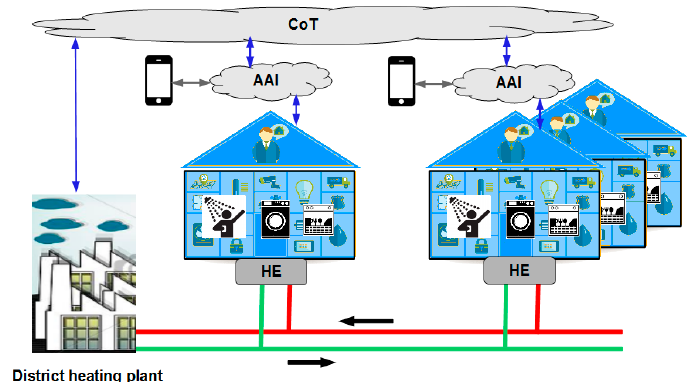
Figure 2. A residential building that contains two Artificial Intelligence AI equipped smart apartments.